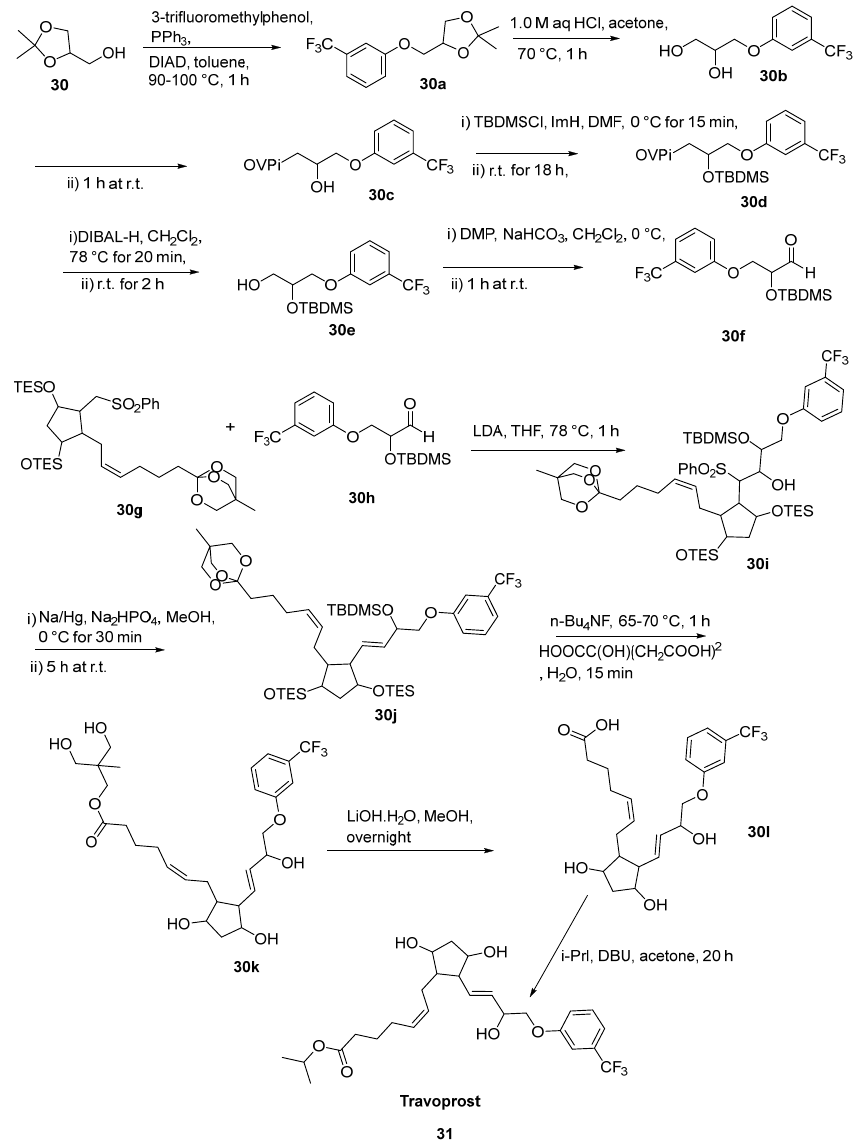
Figure 17. Synthesis and structure of